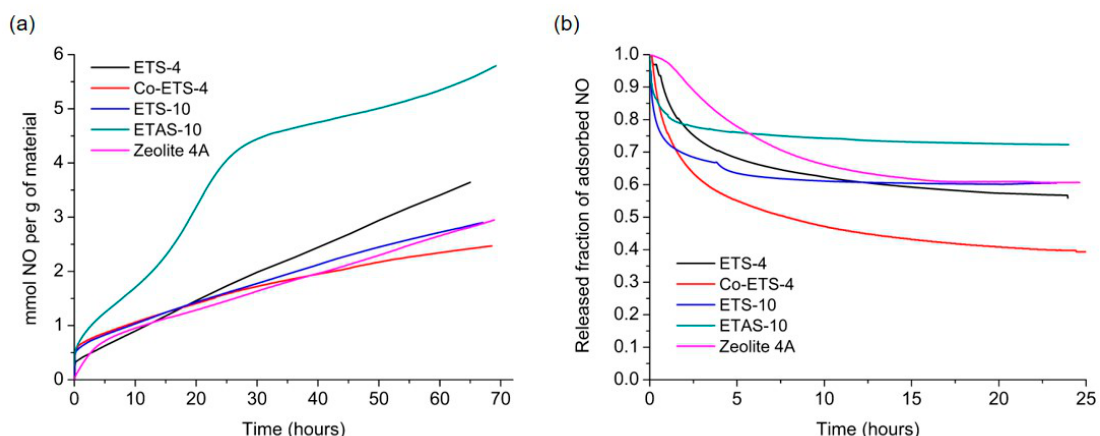
Figure 2. Nitric oxide adsorption and release isotherms at 25 °C on zeolite 4A and on different titanosilicates using a gravimetric apparatus. ( a ) NO adsorption kinetic profiles performed at 80 kPa and ( b ) NO release kinetics in the gas phase using high vacuum. The values released are related to the amount of NO adsorbed by each material. Results from titanosilicates were taken from previous works [17,18].